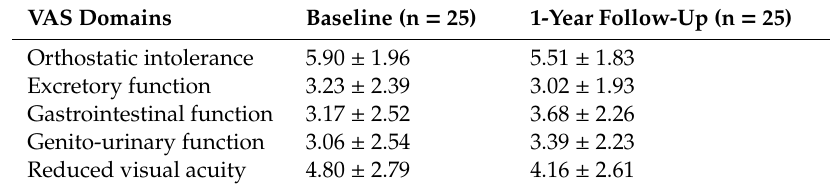
Table 6. VAS autonomic symptom assessment comparison between baseline and 1-year follow-up.